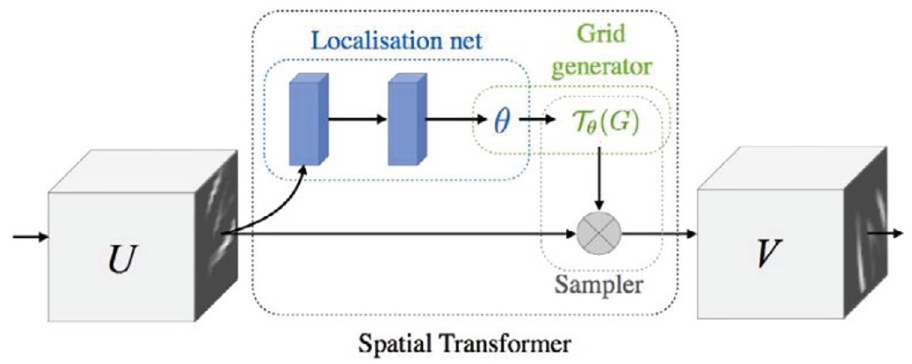
Fig 3. The components of spatial transformer network [27].